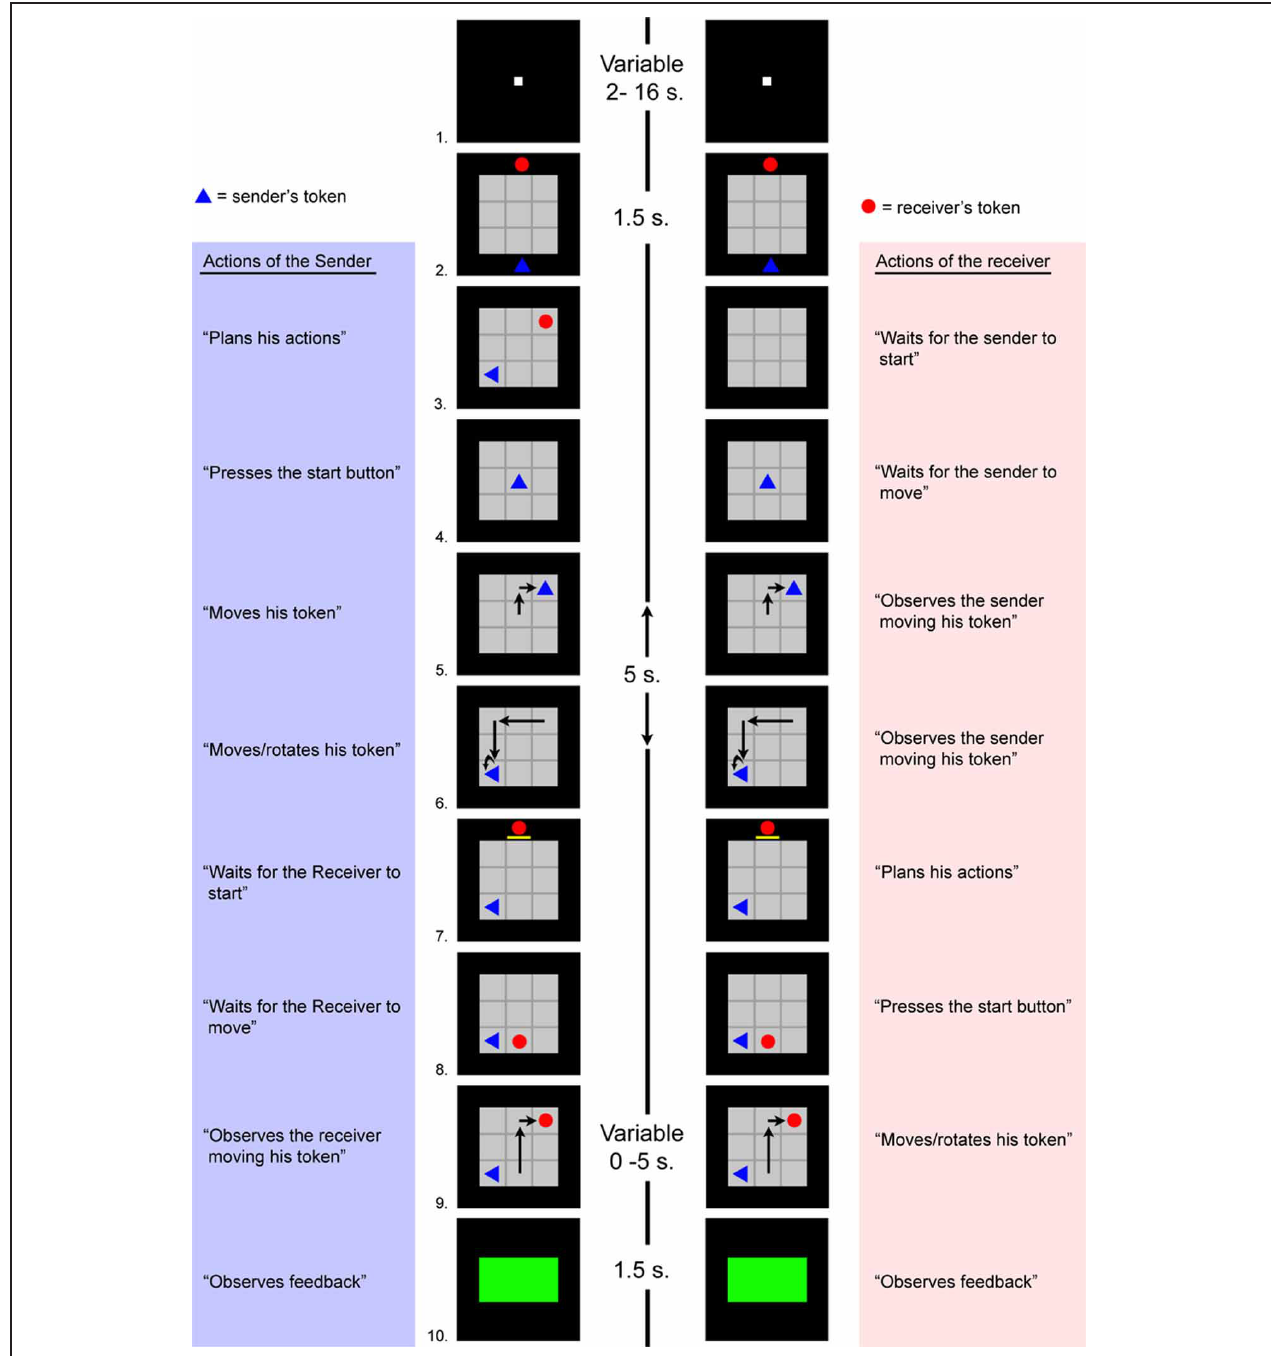
FIGURE 2 | A timeline corresponding to the sender’s and receiver’s observations and actions during the OLD trials. The sender and the receiver saw the images presented in the left and right column, respectively. A trial started with a fixation point presented on the screen (#1). After 2s the game board and the tokens appeared (#2). Then the goal configuration was shown to the sender, and not to the receiver. The goal configuration consisted of two tokens inside the game board (#3). The sender had unlimited time to look at the goal configuration and plan his moves. After the sender pressed the start button, all tokens disappeared and the sender’s token appeared in the center of the game board (#4). The sender had 5s to